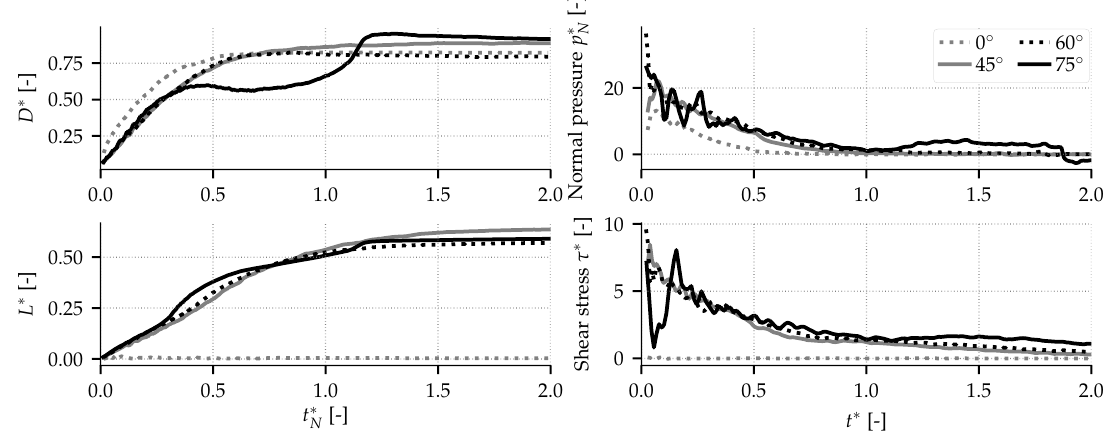
Figure 17. Influence of the impact angle on the transient of a cube presenting its edge parallel to the tangential velocity component.